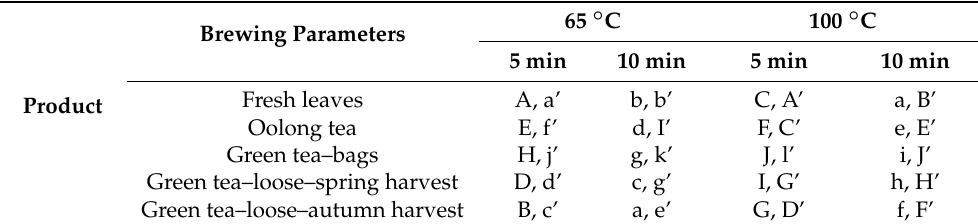
Table 2. Statistical analysis of the influence of brewing parameters on the epigallocatechin gallate content.